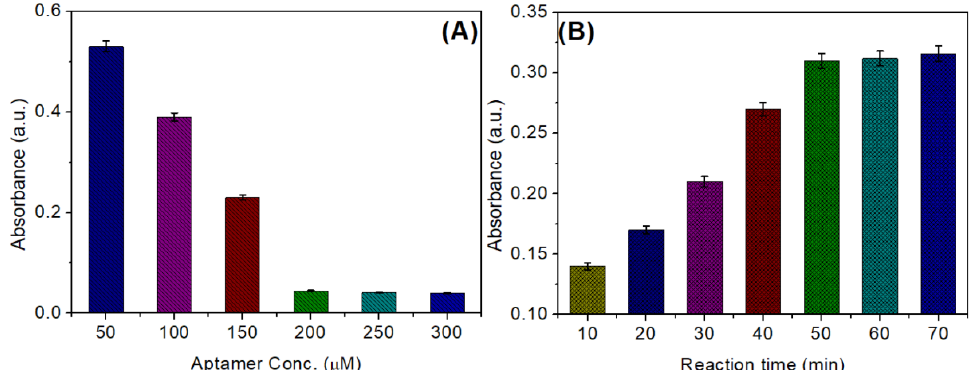
Figure 4. Effects of ( A ) aptamer concentration in the preparation of magnetic aptasensor and ( B ) reaction time between aptamer and target CEA on the spectrometric absorbance of aptasensor. (Note that each data point represents the average value obtained from three measurements. The error bars represent the 95% confidence interval of the mean for y-axis concentrations.)